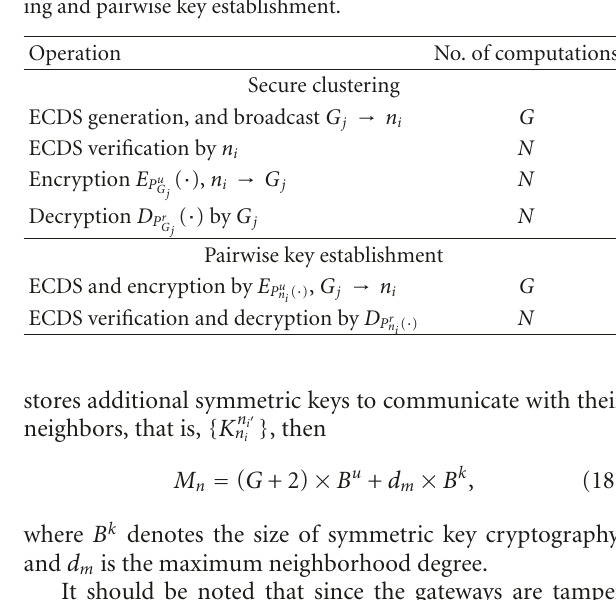
Figure 4: The impact of number of hops on link compromise probability.